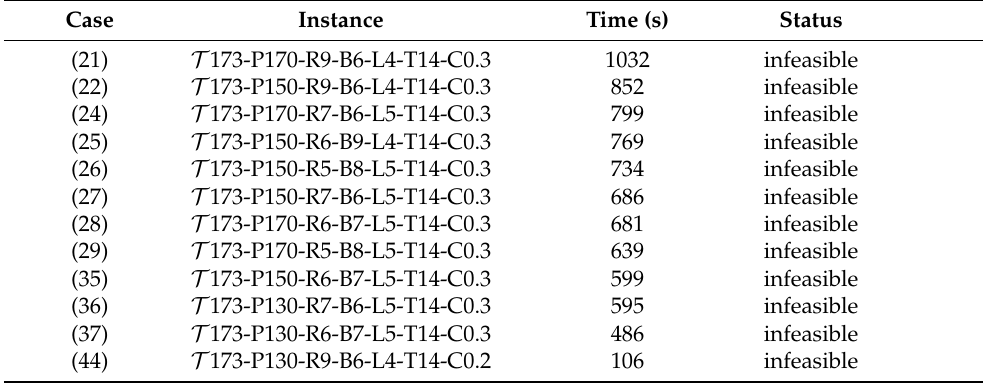
Table 6. Gurobi results for infeasible problem